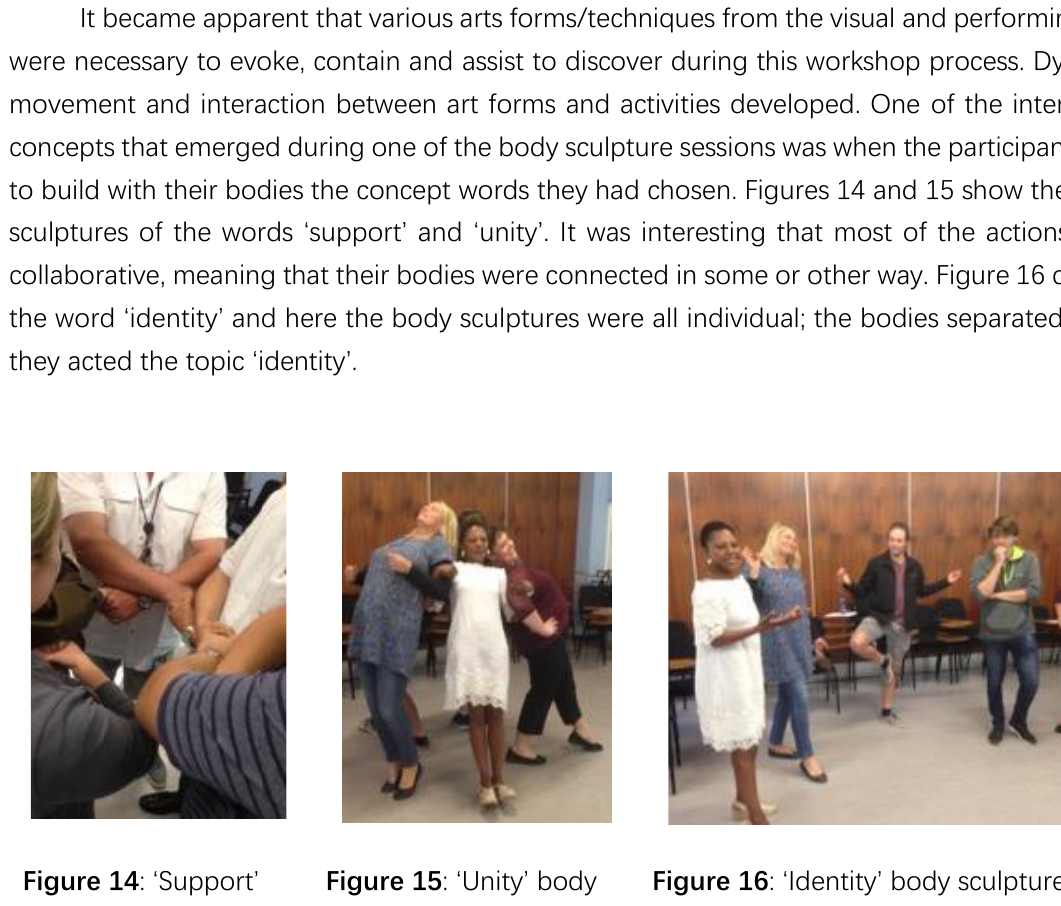
Figure 14 : ‘Support’ body sculpture